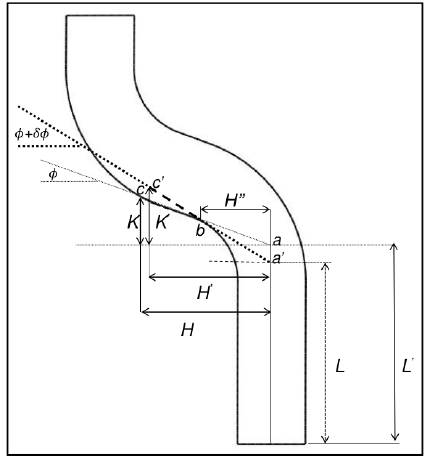
Figure 17: Effect of changing V-band angle on the parameters ( H , K and L ) used in the theory.